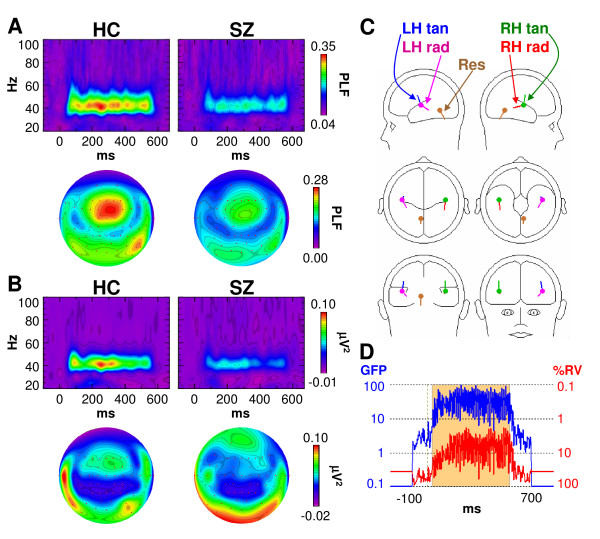
Analyses of scalp EEG data. (A) Time-frequency and topographic maps of phase locking factor (PLF) for healthy controls (HC) and schizophrenia patients (SZ). The time-frequency maps show responses at electrode Fz. Topographic maps are oriented so that the top of the map is anterior and the bottom is posterior. (B) Time-frequency and topographic maps of evoked power for HC and SZ, as in A. (C) Dipole model of the ASSR based on the HC grand average. Labels are for left hemisphere tangential (LH tan), left hemisphere radial (LH rad), right hemisphere tangential (RH tan), right hemisphere radial (RH rad), and Residual (Res) dipoles. (D) Global field power (blue) of the scalp ASSR and percent residual variance (%RV) of the dipole model (red). The period during which the dipole model was fit (30–550 ms) is shaded.